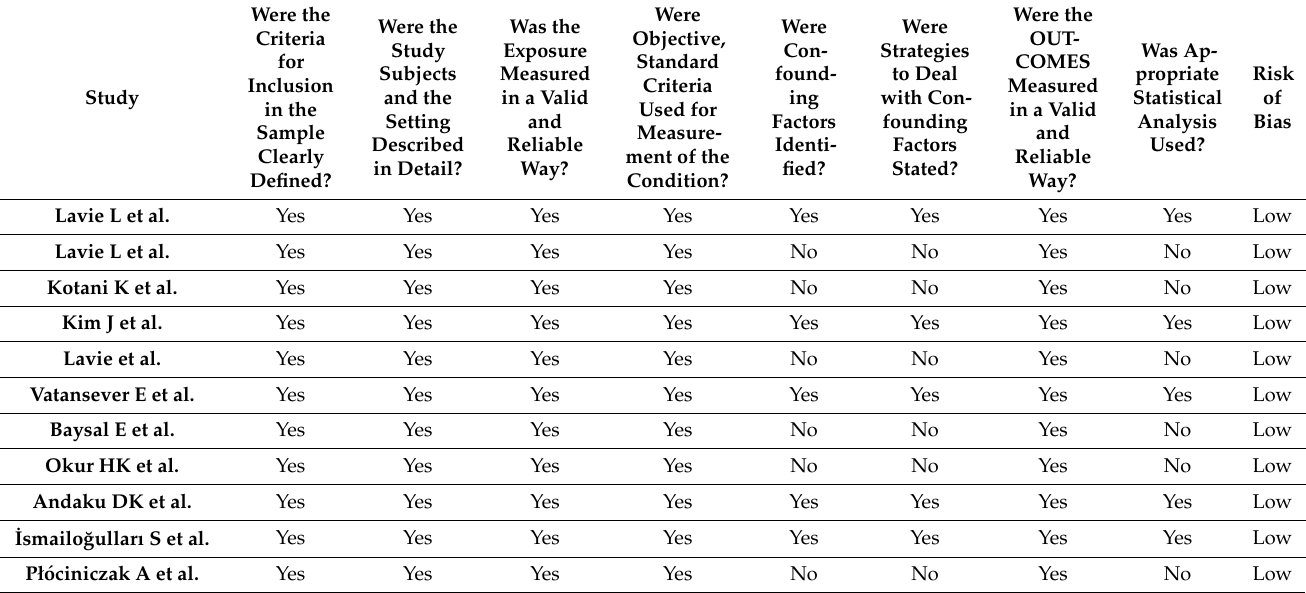
Table 2. The Joanna Briggs Institute critical appraisal checklist.